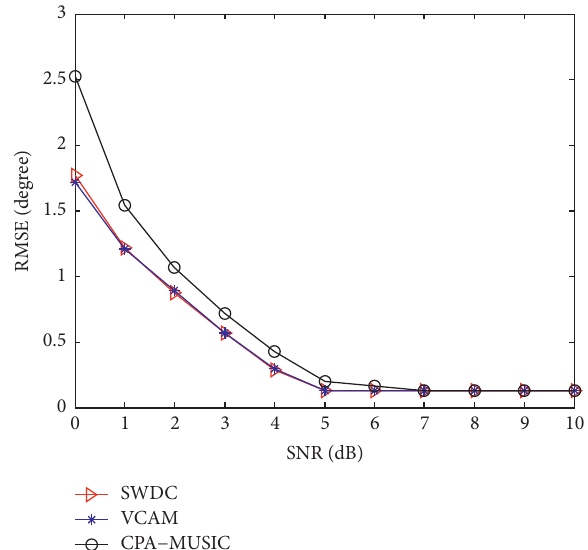
Figure 5: RMSE versus SNR with the number of snapshots being 600.